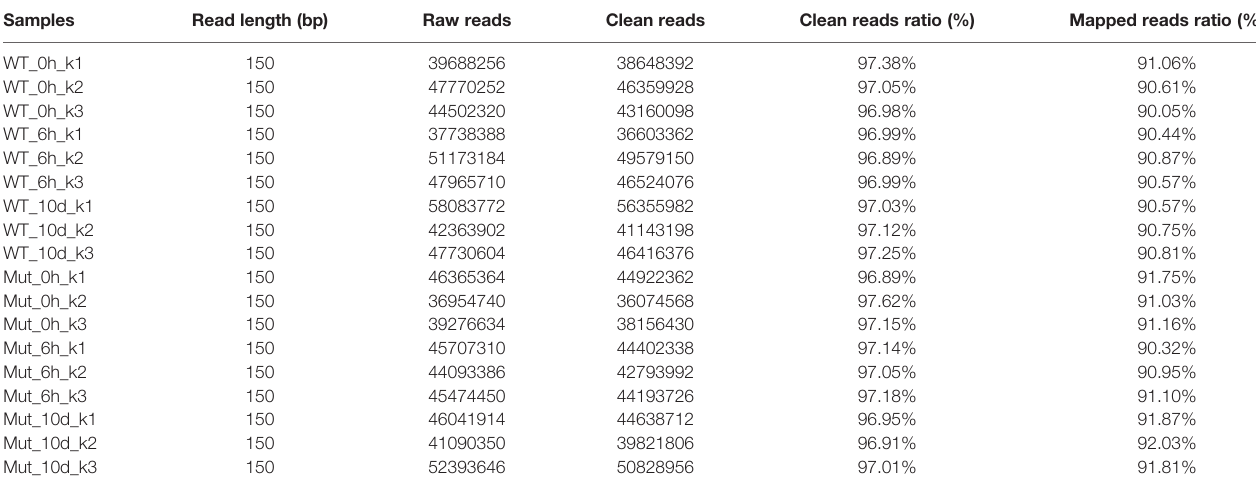
TABLE 1 | Summary of the sequencing data. Each sample was triplicated as indicated by the number after the hyphen, e.g., WT_0h_k1, WT_0h_k2, WT_0h_k3. Samples